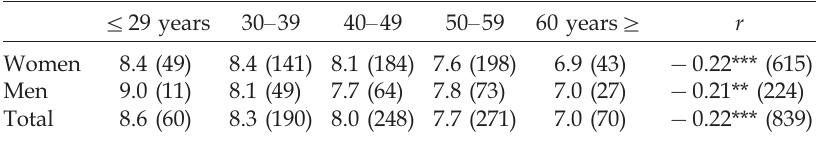
Table 1. Subjecti v e work ability (compared to the best e v er) by age and gender. Municipality employees. Mean and Pearson r. ( N